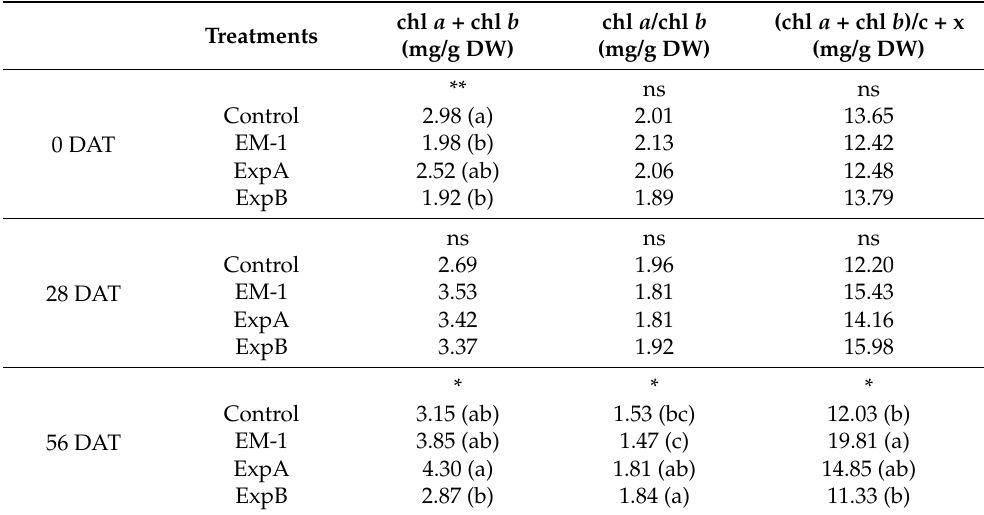
Table 2. Comparison of total chlorophyll (chl a + chl b ), the ratio of chl a and chl b and carotenoids (carotene and xanthophylls: c + x) in the leaf material of creeping bentgrass at 0, 28 and 56 DAT for the untreated control, EM-1, ExpA and ExpB.